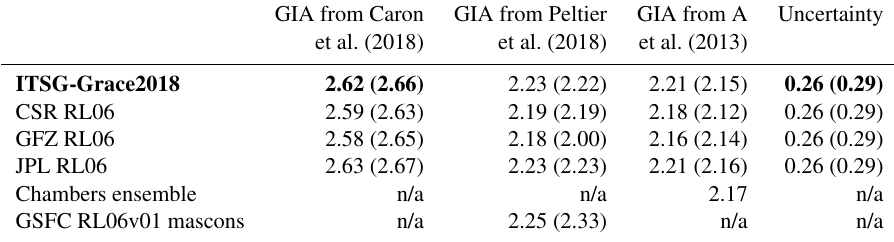
Table 1. OMC linear trends (millimetre equivalent of global mean sea level per year) over January 2003–August 2016 from different GRACE solutions. Each column uses a different GIA correction as indicated in the header line. The first four lines of data show results from different SH solution series generated within SLBC_cci. Numbers in brackets are for the ocean domain between 65 ◦ N and 65 ◦ S. The last two lines show external products, namely the ensemble mean of the updated time series by Johnson and Chambers (2013) and the GSFC RL06v01 mascon solution. The last column shows the assessed total uncertainty of the trend. The preferred solution is printed in bold font. n/a: not